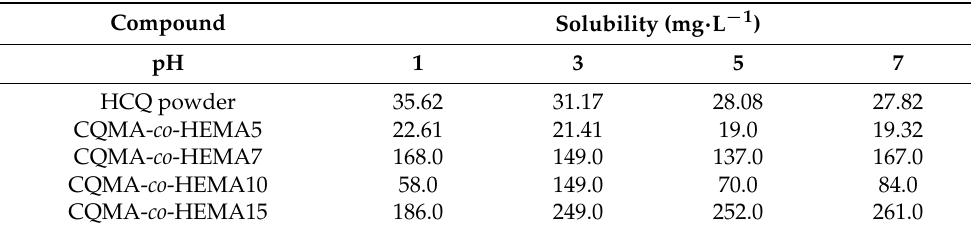
Figure 15. Release behavior of HCQ from CQMA-co-HEMA systems with different HCQ content versus time in different pH media. Table 5. Solubility of HCQ in different pH media at 37 ◦ C deducted from the maximum amount of HCQ released from CQMA- co -HEMA drug carrier